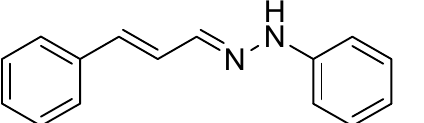
Figure 1. Structure of cinnamaldehyde